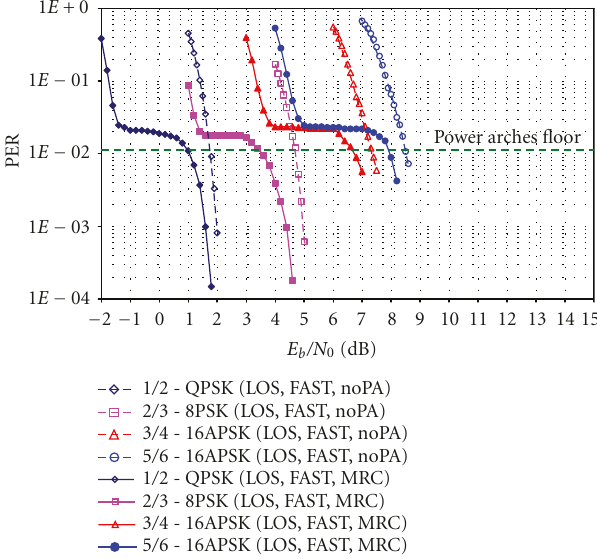
Figure 10: MRC performance in LOS channel condition and train speed equal to 300